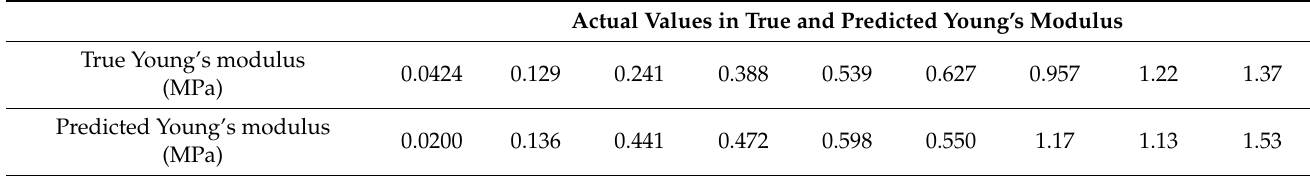
Table 1. Prediction results of Young’s modulus by machine learning-based analysis in Figure